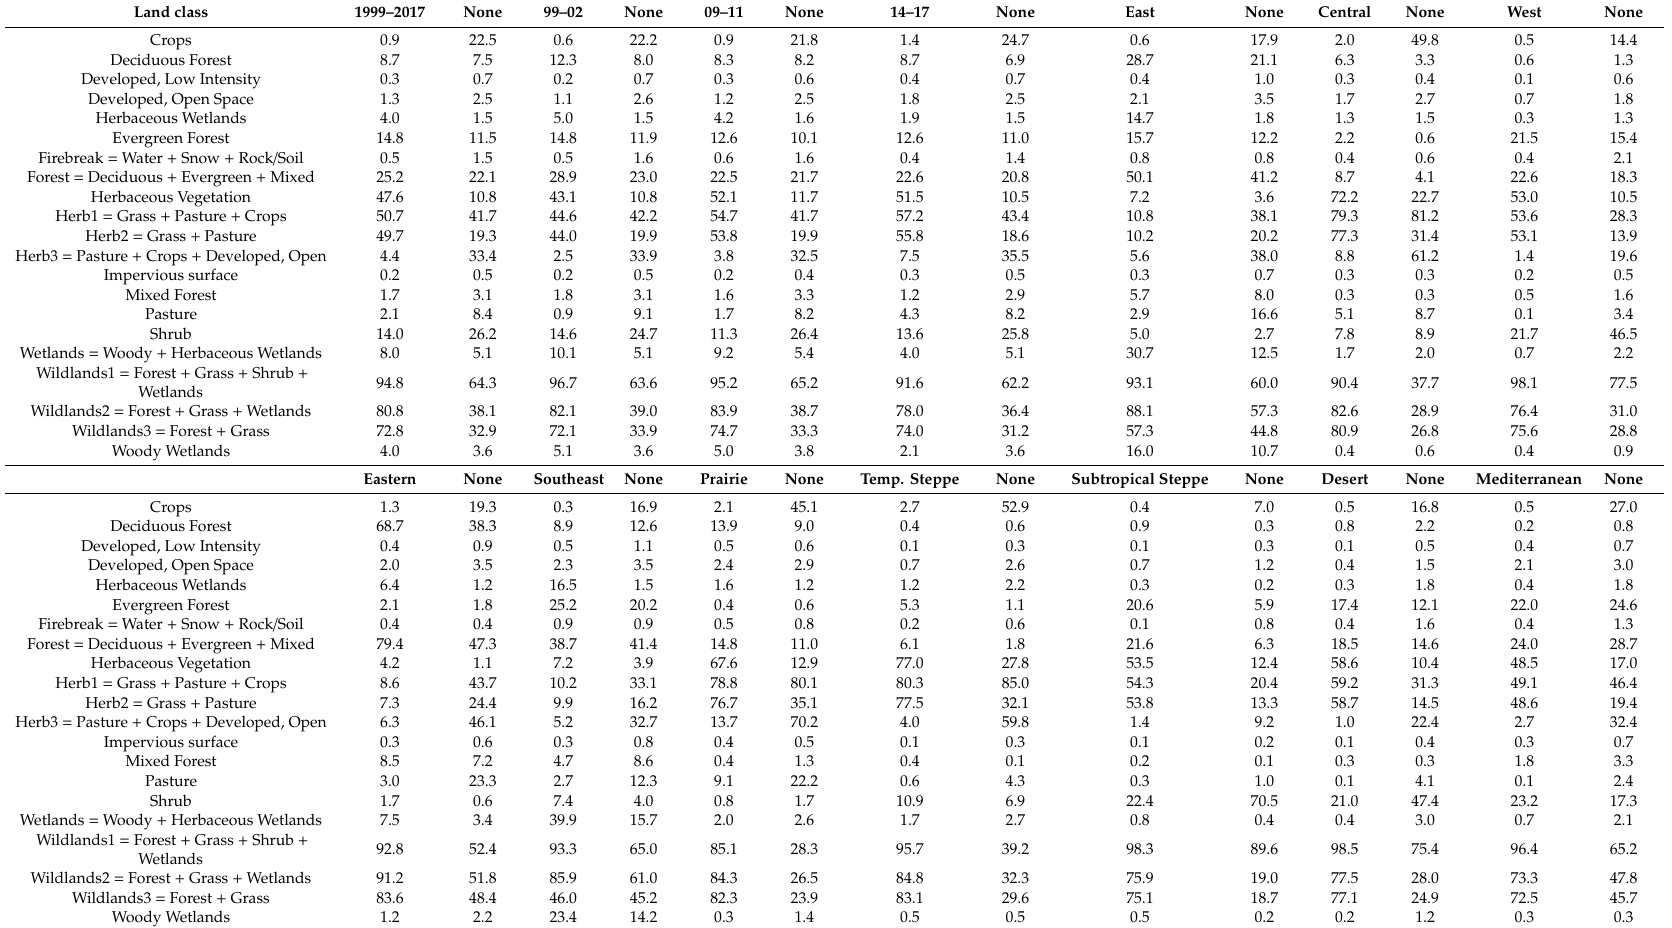
Table 1. Variables and values (% area) from the National Land Cover Database for recorded fires and samples with no known fires in the conterminous United States by years, region, and ecoregion (years 1999–2017 for each region and